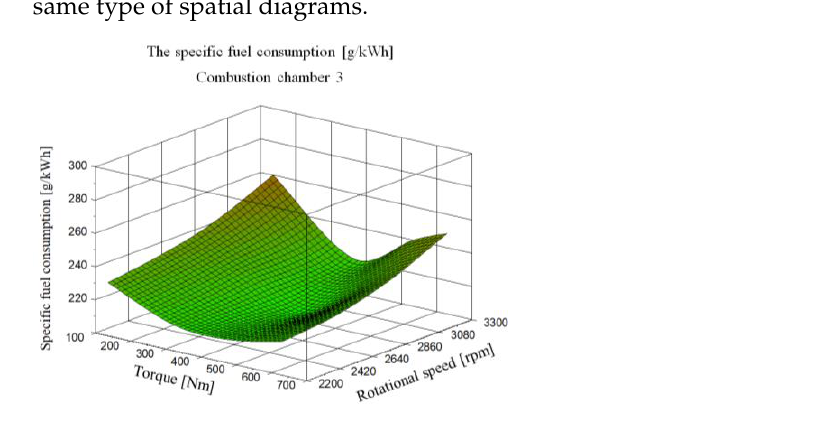
Figure 26. The specific fuel consumption for the engine equipped with the combustion chamber 3.